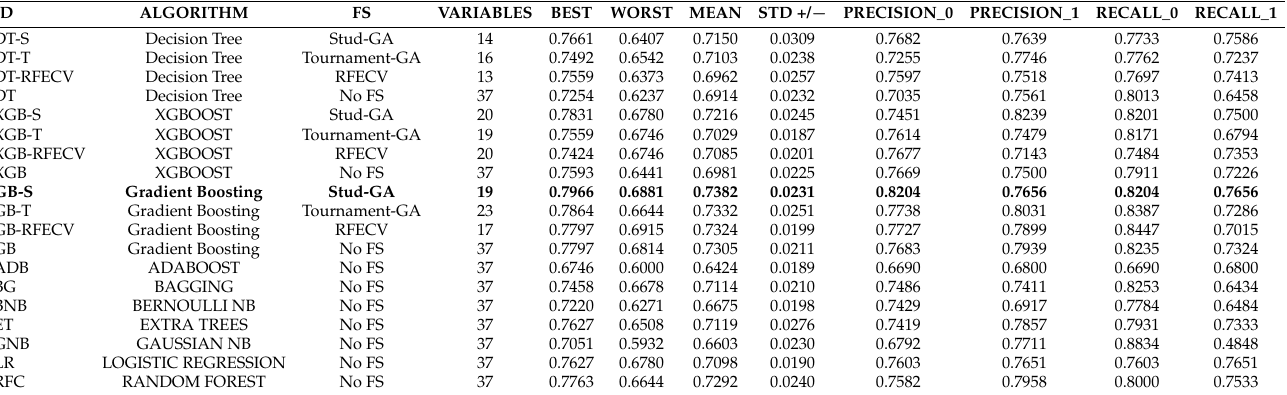
Table 2. Results of the different algorithms for the set of variables with pathologies. The table shows the algorithm, selection method, number of variables used, best case, worst case, mean, and standard deviation. The algorithm with the highest mean is marked with bold font.